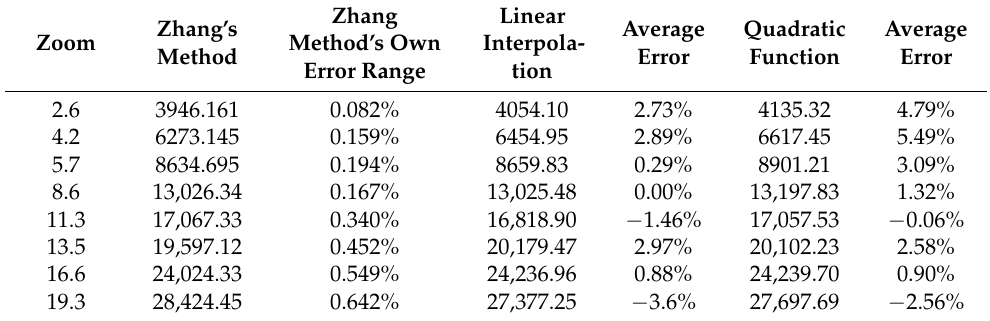
Table 4. Comparison between focal lengths estimated by different methods and the ground